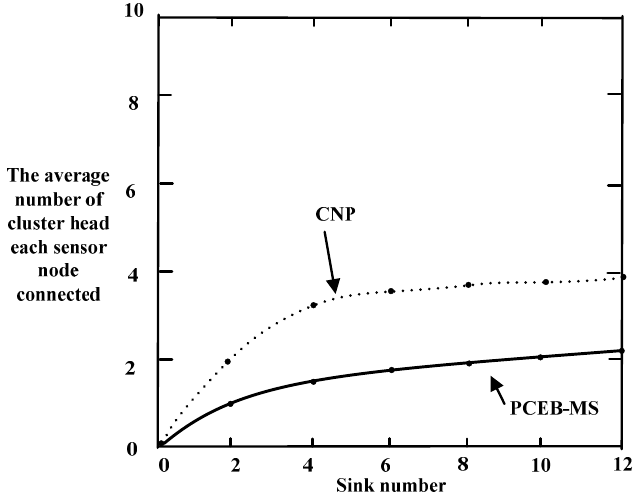
Figure 11. Cluster interface comparison.